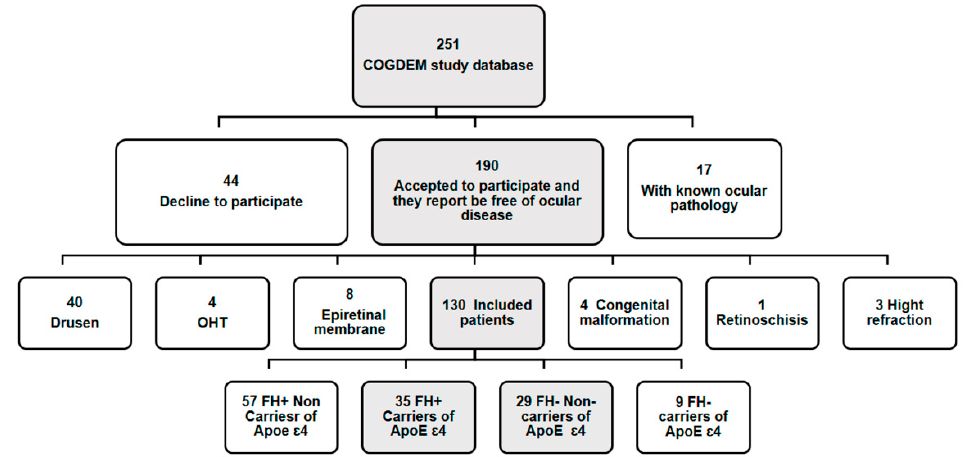
Figure 1. Flow diagram of patient’s inclusion. (COGDEM): “The cognitive and neurophysiological characteristics of subjects at high risk of developing dementia: a multidimensional approach”; (FH + ), subjects with a family history of Alzheimer’s disease (AD); (FH − ) subjects without a family history of AD. In greyscale, patients who participated in the ophthalmological study and were included in our study.